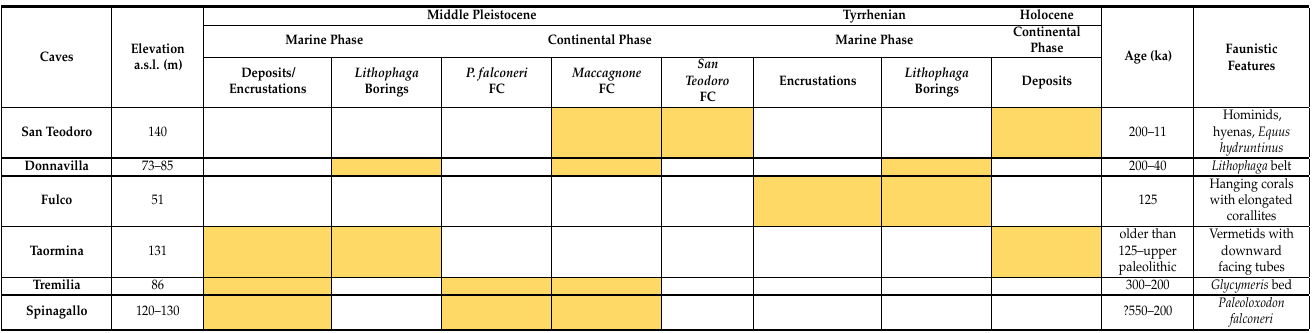
Table 1. Summary of the main distinctive features of the examined